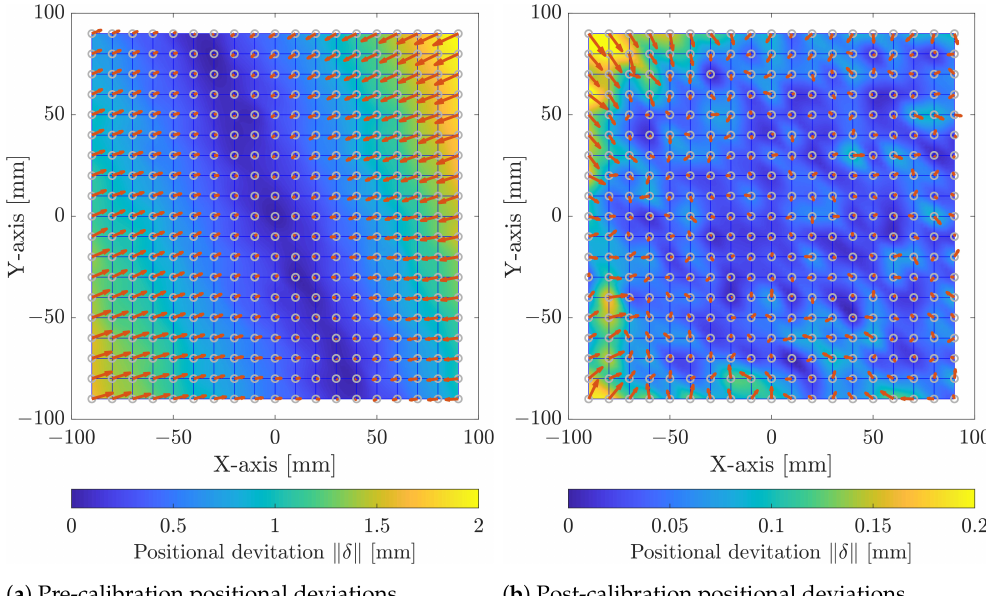
Figure 7. Pre- and post-calibration positional deviations δ , respectively ( a , b ). The grey circles indicate the target positions P c , while the direction and scale of the red arrows indicate the direction and scale of the positional deviation. Note that the scaling of the colour bar is a factor of 10 smaller in ( b ) compared to ( a ).